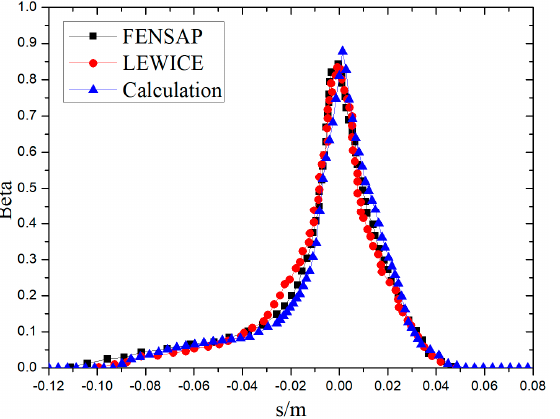
Figure 6. Comparison of collection coe ffi cients for the NACA23012 veri fi cation example.